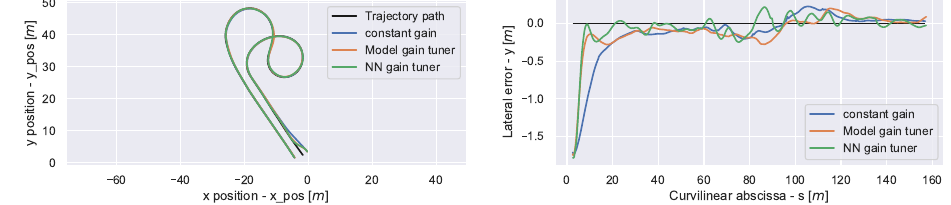
Figure 6. The trajectory ( left ) and the lateral error ( right ), over the total